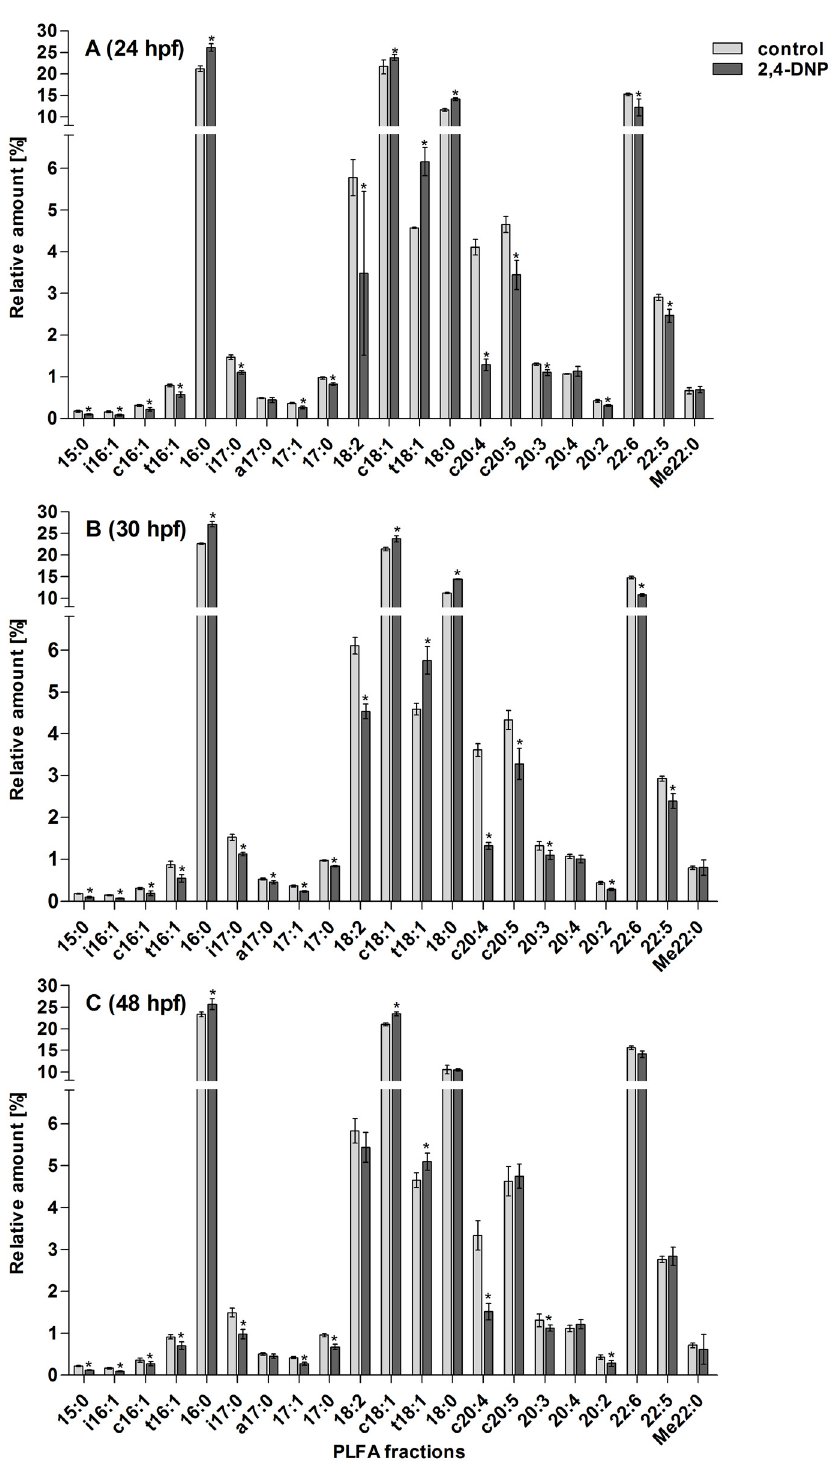
Fig 4. PLFA patterns of untreated (light grey) and 2,4-DNP-treated (dark grey) embryos at 24 (A), 30 (B) and 48 hpf (C). * indicates significant differences between untreated and 2,4-DNP-treated embryos (p < 0.05; Student's t-test). n = 3 – 4 with 50 pooled embryos per n. Note that the y-axes are divided into two sections with different scales.